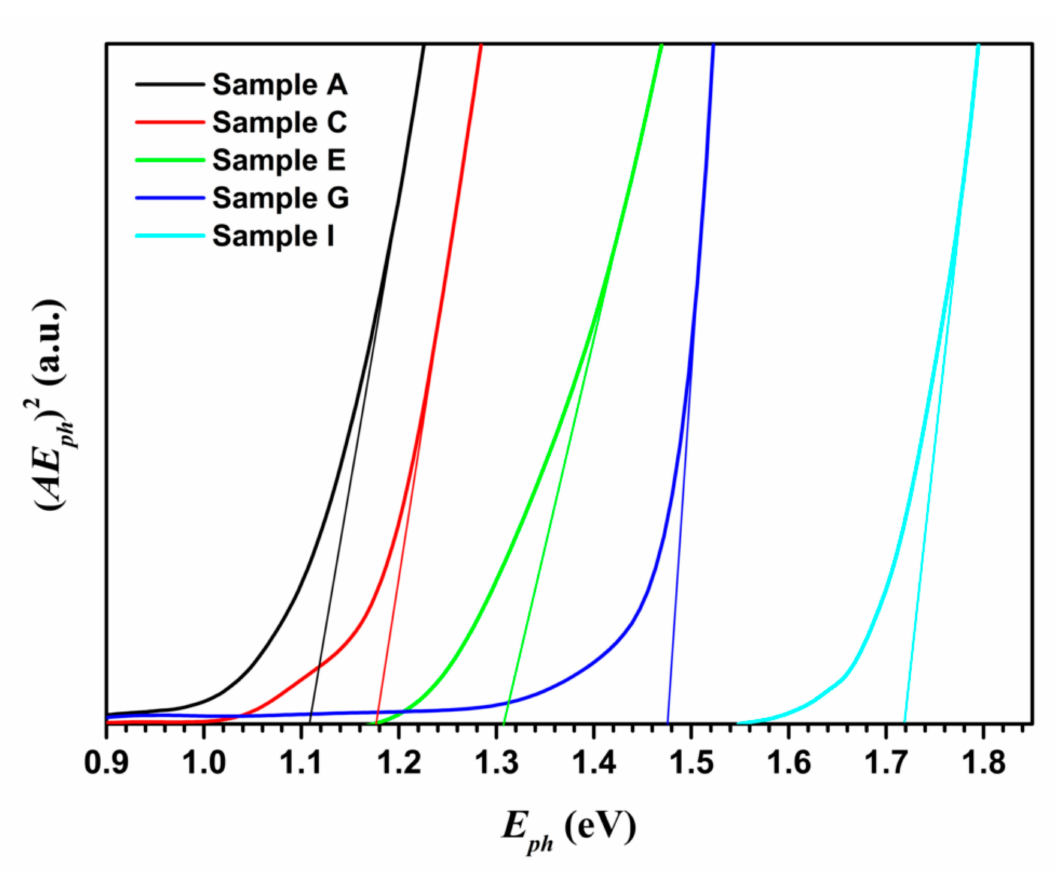
Figure 4. Tauc plot of ( AE ph ) 2 versus E ph of CuIn 1 − x Ga x Se 2